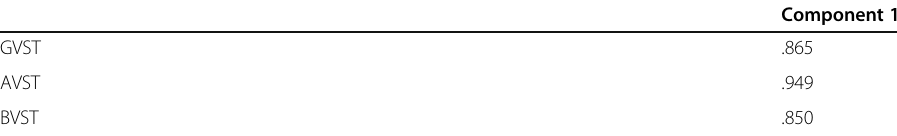
Table 3 Component